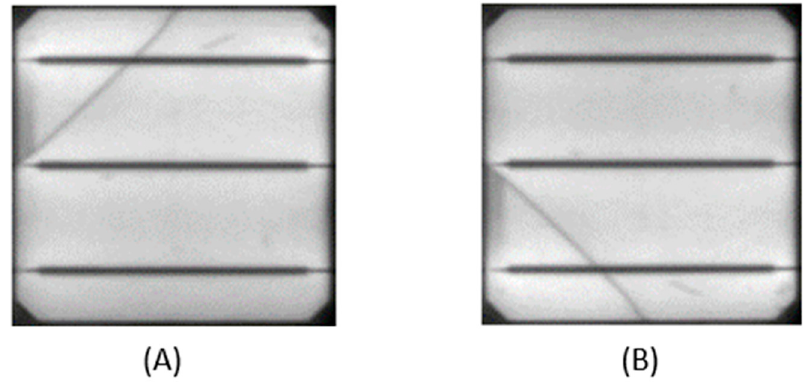
Figure 2. Vertical flipping ( A ) input ( B ) output.